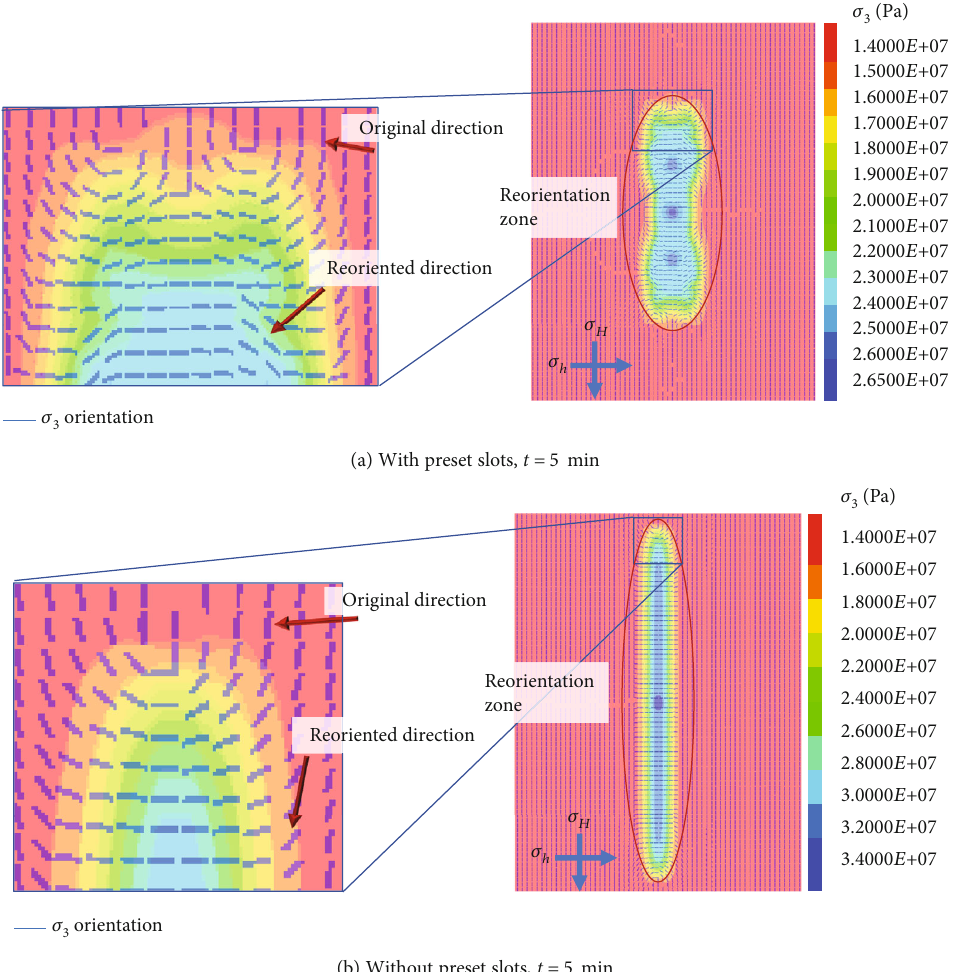
Figure 12: Stress distribution and orientation around hydraulic fractures (a) with and (b) without a regular distribution of hydraulic